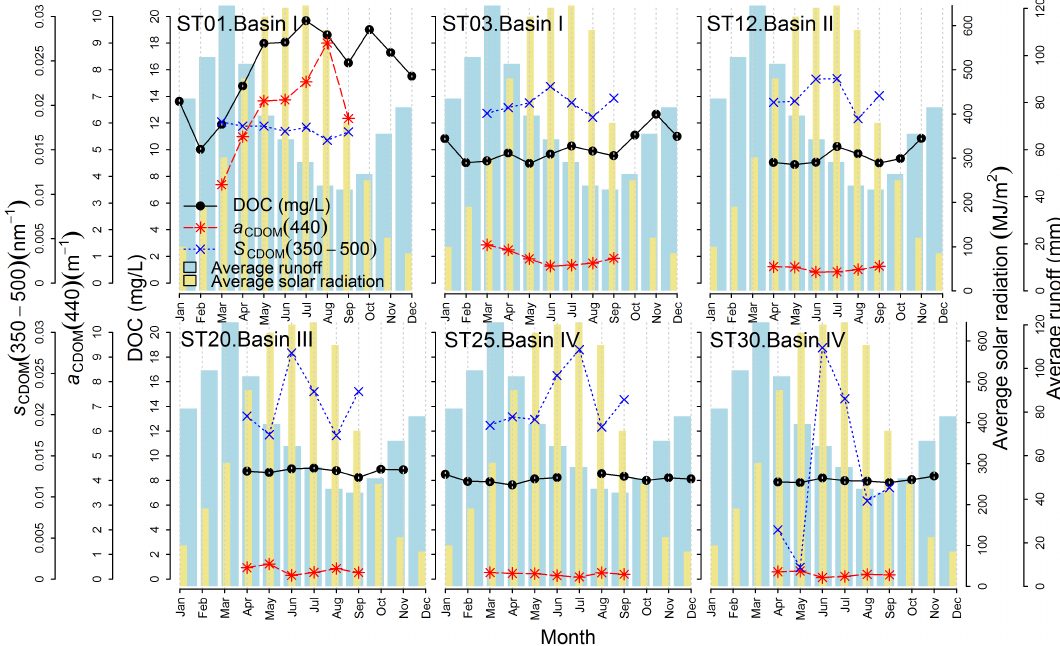
Figure 2. Seasonal a CDOM (440), SCDOM(350–500) and DOC concentration variation in Lake Balaton between January and December 2014 and seasonal variability of run-off in Balaton region (Hungary), monthly means from 1921 to 2007 (modified from Anda and Varga, 2010).